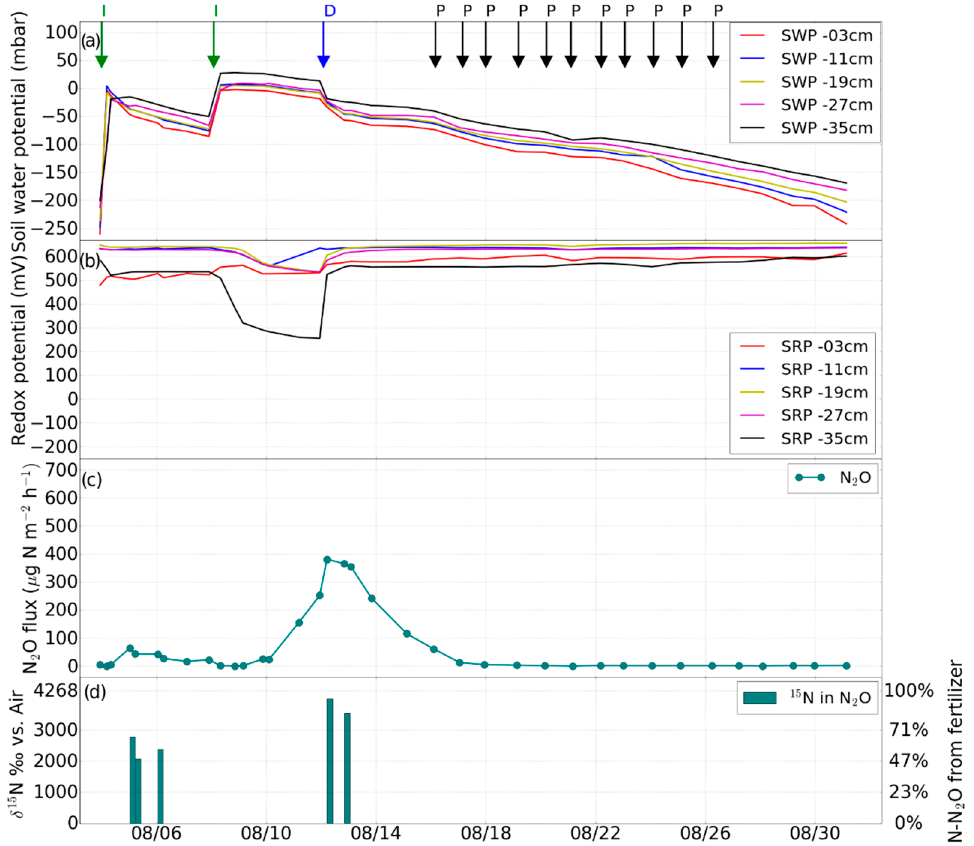
Figure 5. Experiment 4 (post-fertilization saturation phase). Changes in ( a ) soil water potential (SWP), ( b ) soil redox potential (SRP), ( c ) N 2 O flux induced by irrigation (I), drainage (D), desaturation of the soil with pump (P), ( d ) percentage of N 2 O from the added fertilizer.